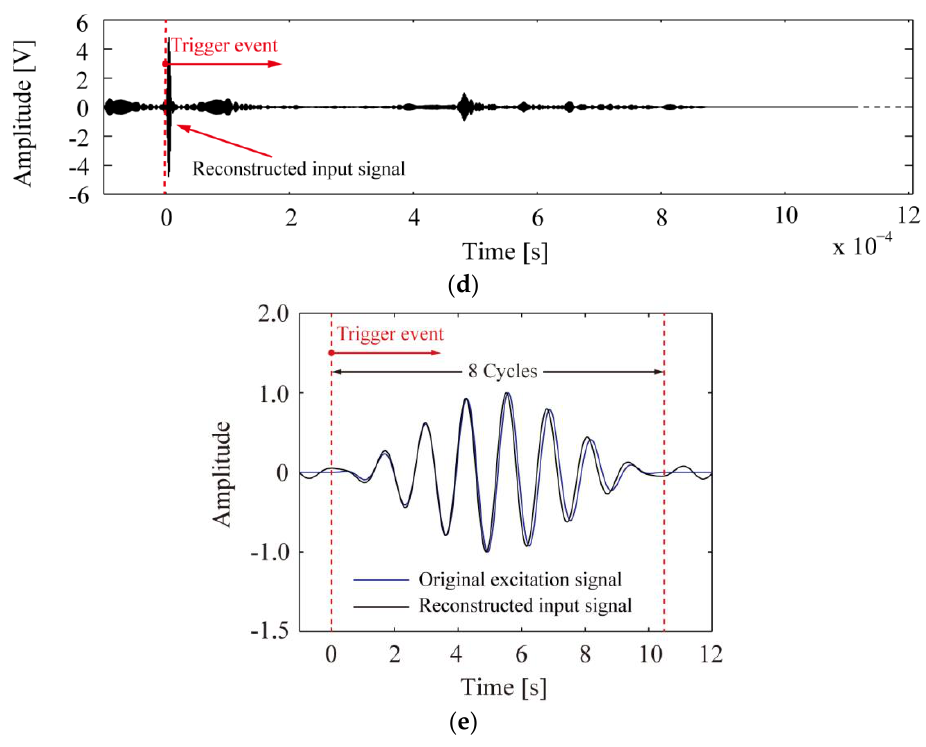
Figure 3. TRM process of multimode and multipath. ( a ) Original excitation signal; ( b ) Received signals of multimode and multipath due to original excitation signal; ( c ) Received signal after TRM; ( d ) Reconstructed input signal; ( e ) Comparison between normalized reconstructed input signal and original excitation signal.